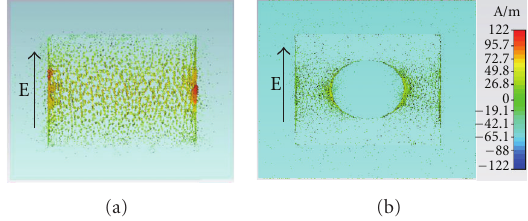
Figure 2: Surface current distribution on (a) rectangular patch of reflectarray and (b) reflectarray rectangular patch element with circular slot in the centre.